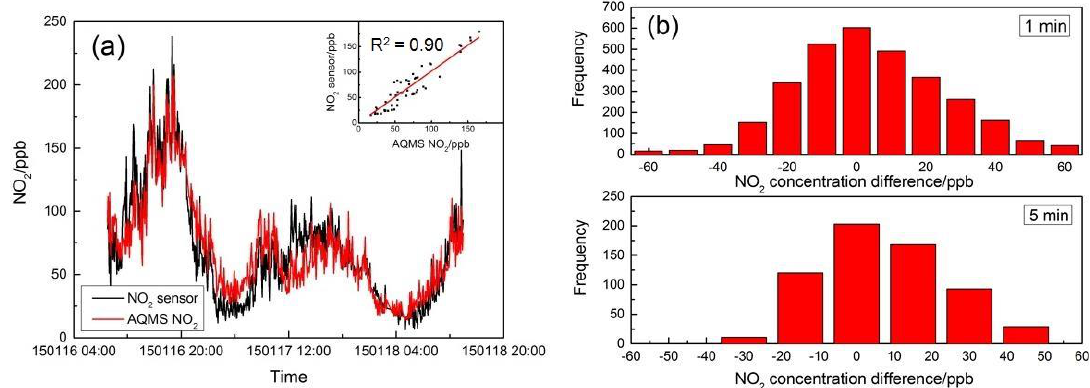
Figure 6. Comparison of the NO 2 concentration from MAS and AQMS. ( a ) Time series of concentration; ( b ) histogram of the concentration difference in the 1-min and 5-min time average.